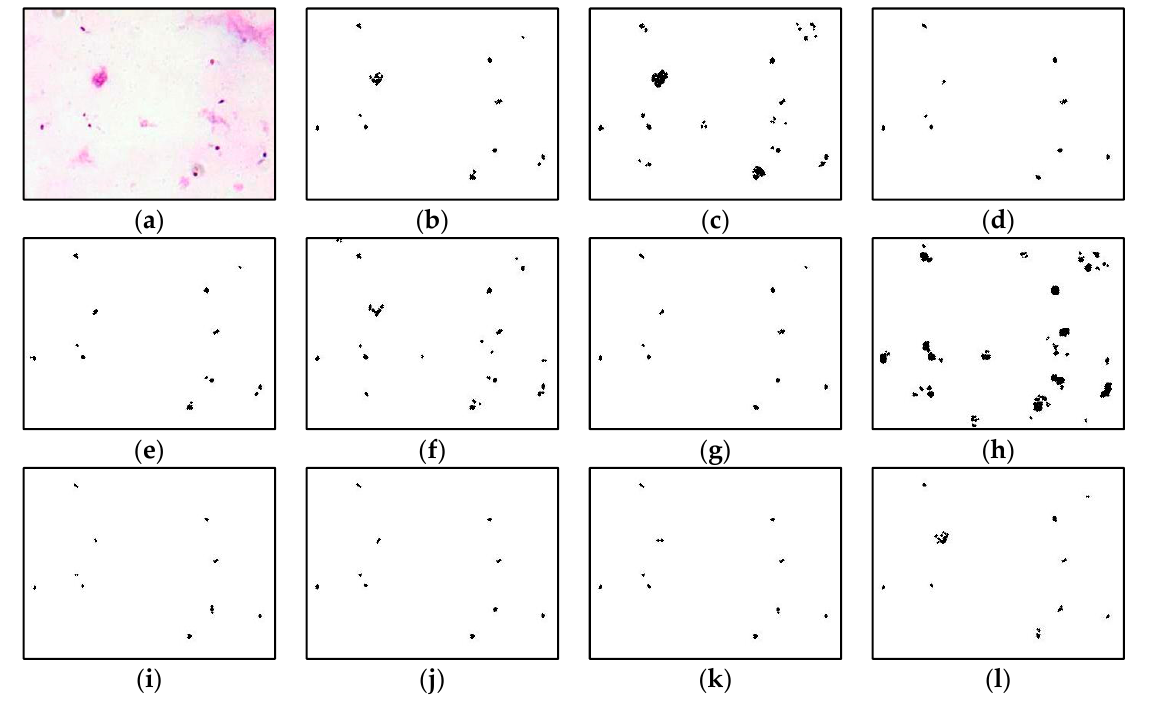
Figure 5. P. falciparum of thick smear in various segmentation techniques of ( a ) original image; ( b ) adaptive thresholding; ( c ) Niblack; ( d ) Sauvola; ( e ) Phansalkar; ( f ) Bradley; ( g ) Nick; ( h ) Feng; ( i ) KM; ( j ) FCM; ( k ) FKM; ( l ) EKM.